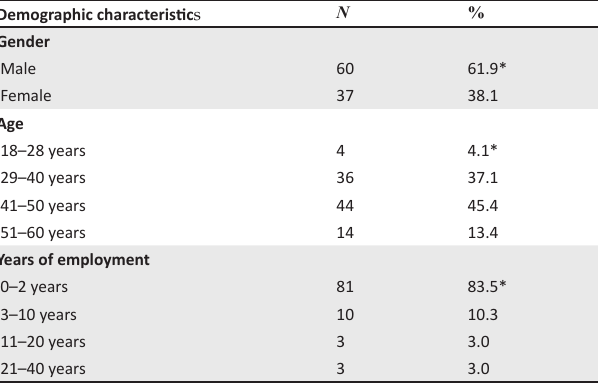
TABLE 1: Demographic characteristics of the participants ( N = 97). Demographic characteristic